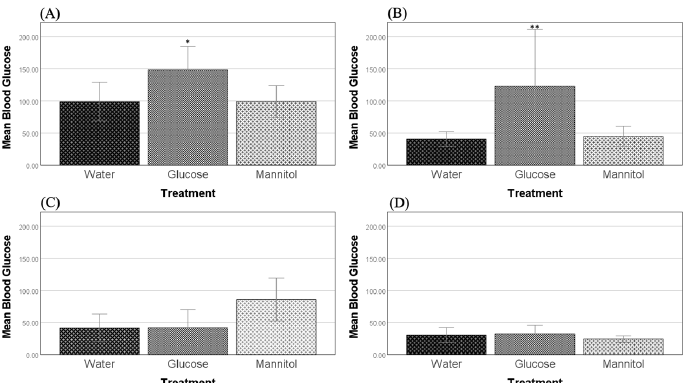
Figure 1. Blood glucose levels. Blood glucose levels were measured after ( A ) 8 weeks and ( B ) 12 weeks of hyperglycemia. At both timepoints, glucose-treated fish had significantly higher blood sugar levels than either water- or mannitol-treated controls (one-way ANOVA, 8 weeks, p = 0.037, p = 0.048, * respectively; 12 weeks, p = 0.010, p = 0.011, ** respectively). Values are means +/ − 95% CI. n = 23 (8 weeks); n = 32 (12 weeks). Four weeks of recovery after either four weeks of hyperglycemia ( C ) or eight weeks of hyperglycemia ( D ) showed that glucose-treated fish were no longer significantly different from either of the controls. Values are means +/ − 95% CI. n = 18 (8-week washout); n = 30 (12-week